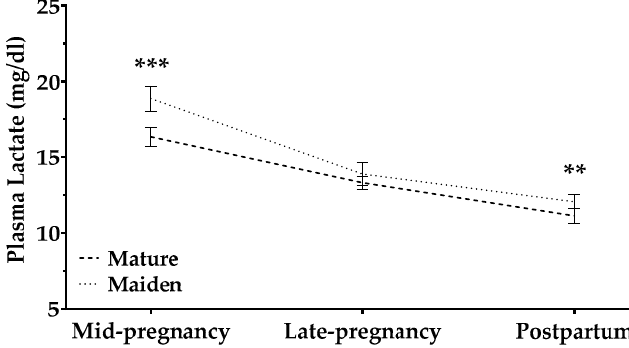
Figure 5. Plasma lactate concentrations (mg/dL) in mature sheep (dashed line) and maiden sheep (dotted lines) throughout the study period. Data are mean ± S.E.M. Asterisks indicate significant differences between age groups (*** p < 0.001; ** p < 0.01).